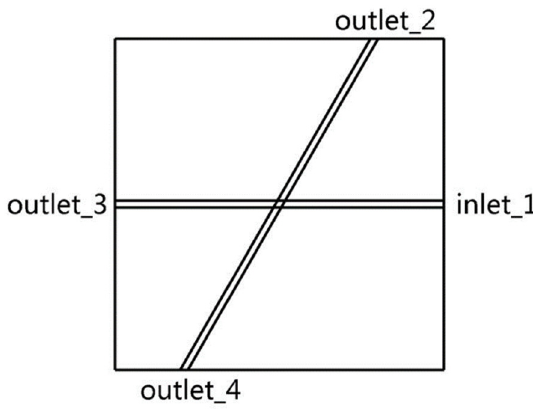
Figure 10. Two crossed fractures model.